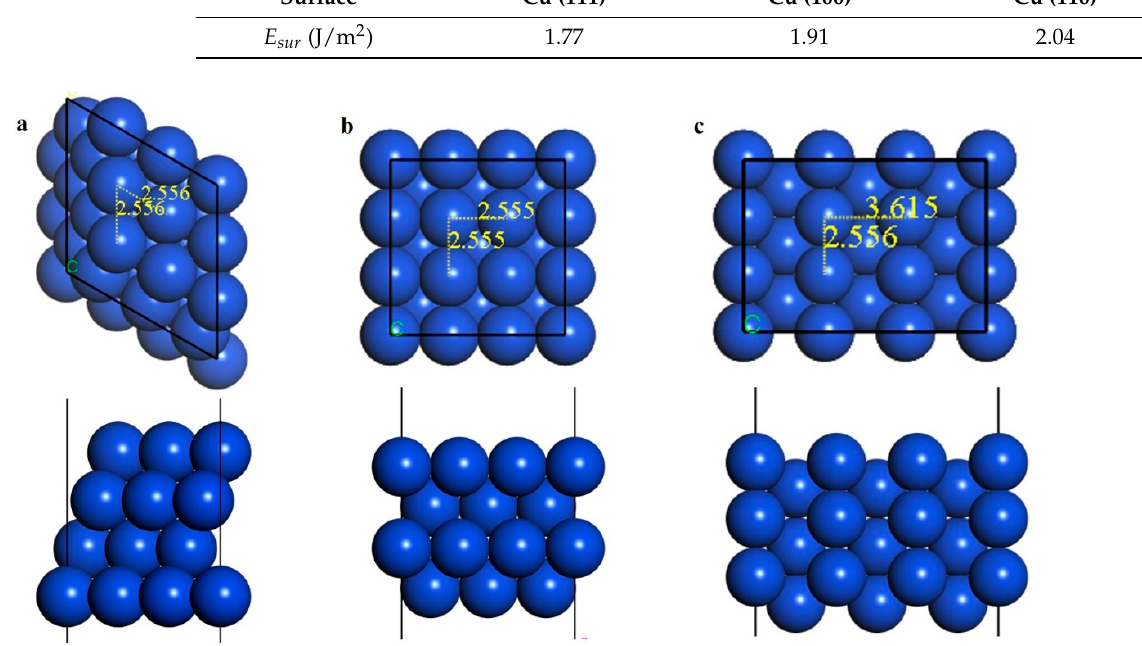
Table 1. Surface energy of Cu (111), Cu (100) and Cu (110) surface, respectively.